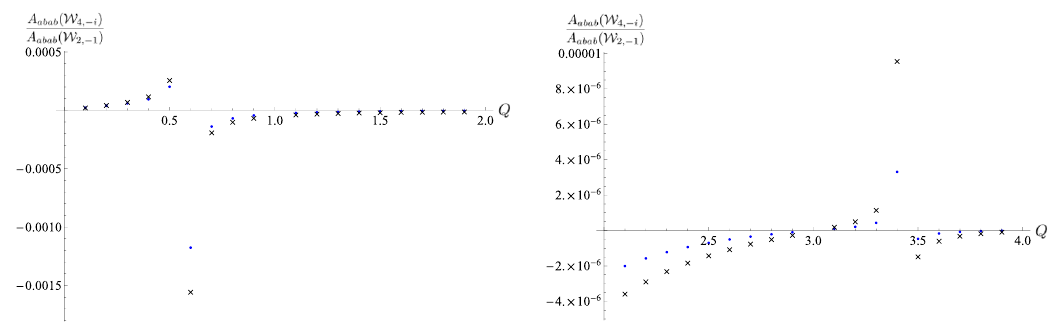
Figure 23 . The amplitude A abab ( W 4 , − i ) normalized with the leading amplitude A abab ( W 2 , − 1 ) in P abab − P abba . Comparison of the lattice results (indicated with × ) and bootstrap results (indicated with • ) in the regions 0 < Q < 2 and 2 < Q < 4